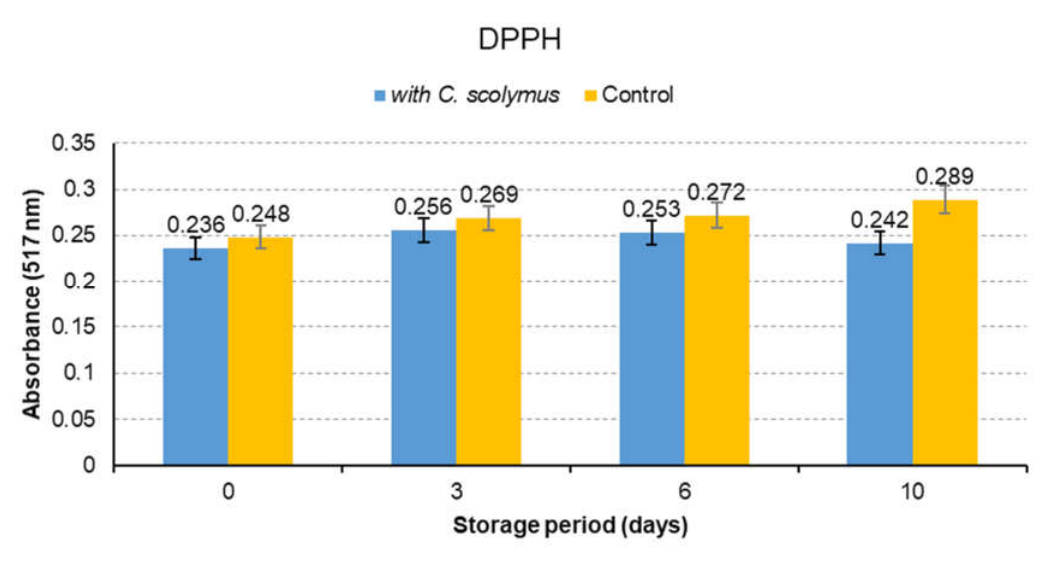
Figure 3. The antioxidant activity of control and marinated meat samples (DPPH assay).